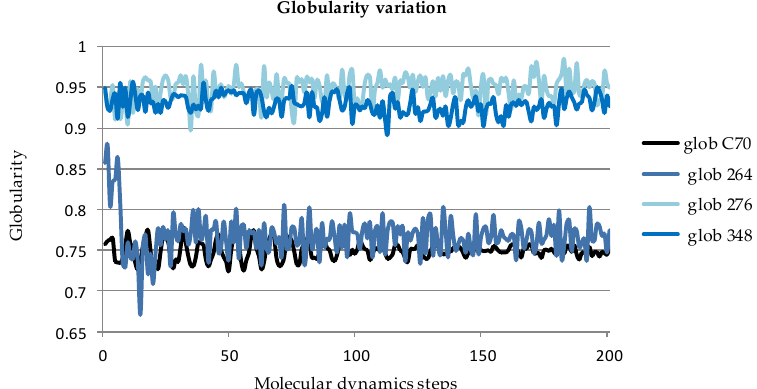
Figure 7. Computed globularity for some rhombellane related structures and fullerene C 70 (see Supplementary Material S1).